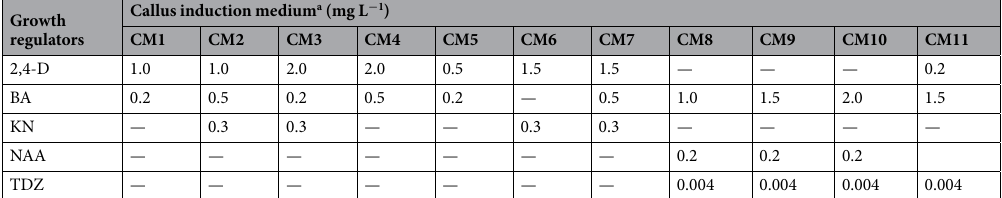
Table 1. Embryogenic tissue induction media (CM1–CM11). a Each medium was composed of DCR